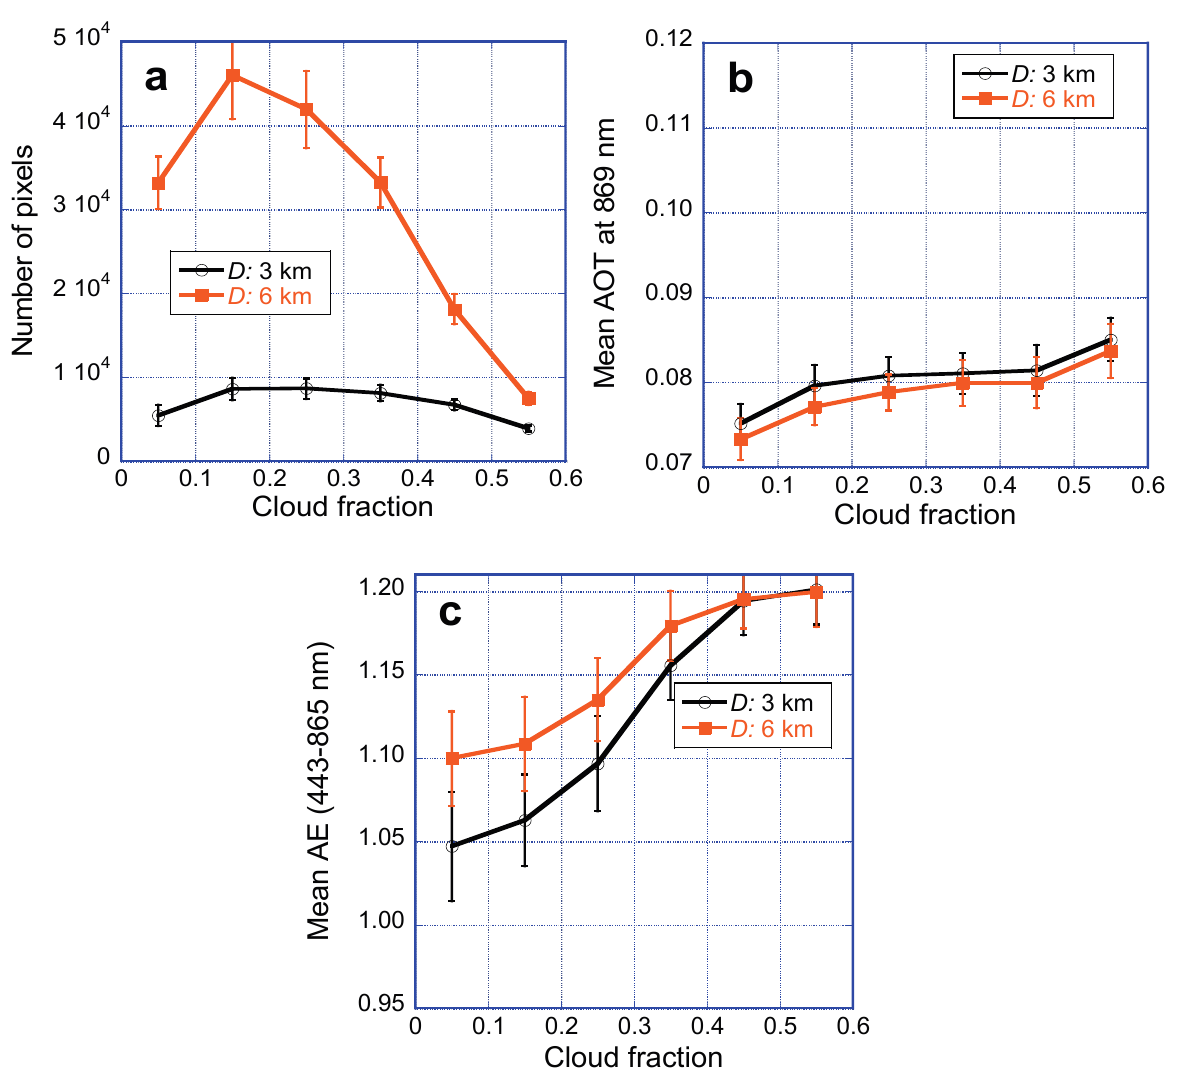
Figure 10. Same as Figure 4, but with the data selection using warnings by all QA flags. ( a ) Number of pixels; ( b ) Aerosol optical thickness; ( c ) Angstrom